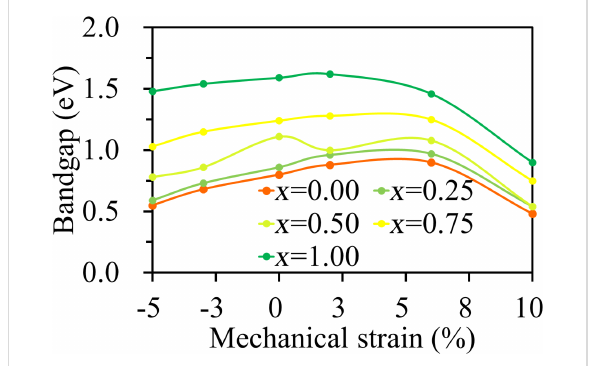
Figure 4: Band gaps of the SnSe 2(1 − x ) S 2 x monolayers as a function of mechanical strain.